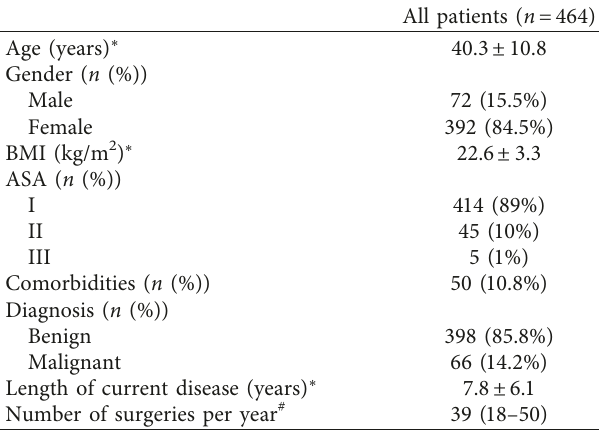
Table 1: Demographics and preoperative variables.